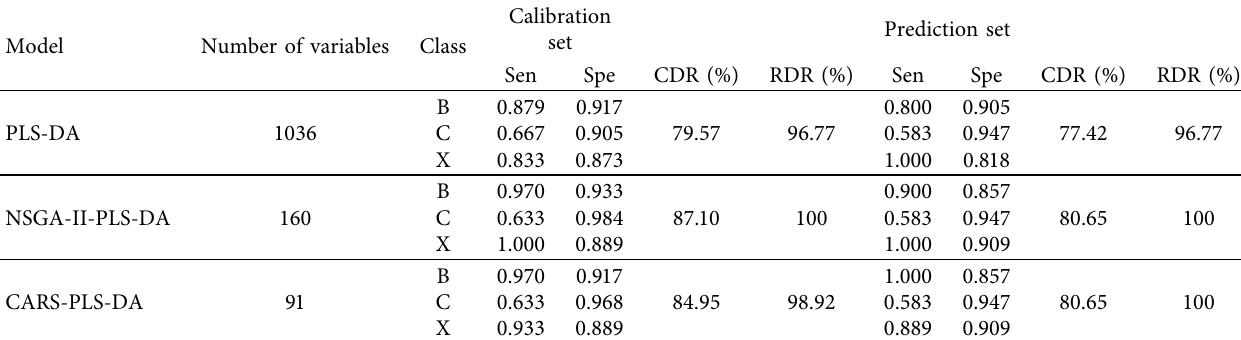
Table 2: Classification results of PLS-DA model based on different variables selection methods.